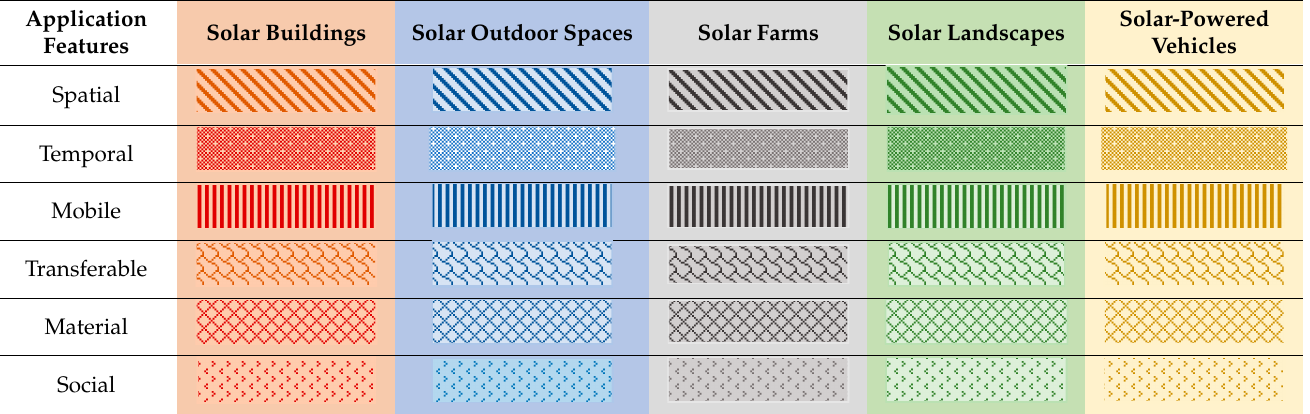
Table 1. Solar Architecture Table template.